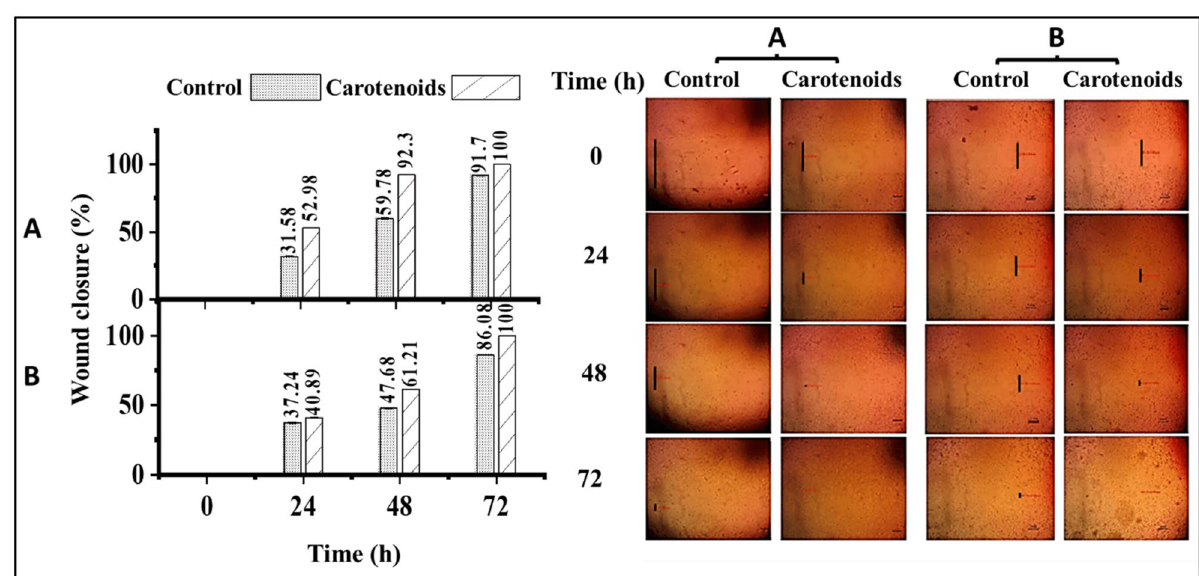
Figure 10. Wound closure percentage using Kocuria sp. RAM1 carotenoids of ( A ) human skin fibroblasts (HSF) and ( B ) oral epithelial cells (OEC) at different time intervals (0, 24, 48 and 72 h). Cells were injured by a straight-line scratch across the monolayer, and photographs were captured at different time intervals (0, 24, 48 and 72 h). The data represent the mean ± SD (n =